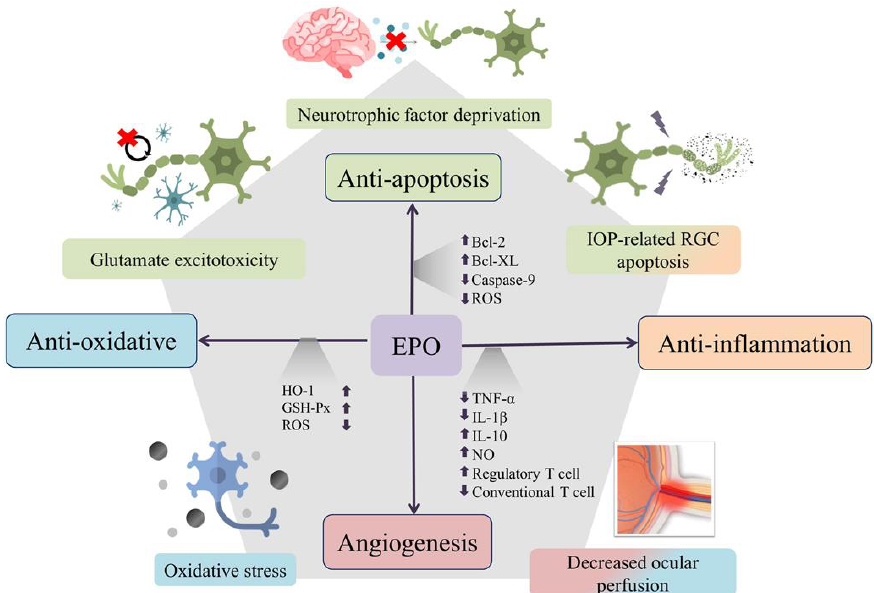
Figure 1. Erythropoietin (EPO) is neuroprotective through its antiapoptotic, antioxidative, and anti-inflammatory effects. The multifunctionality of EPO is used to target the multicausal mechanism of glaucoma. Through upregulation of antiapoptotic proteins Bcl-2 and Bcl-XL, inhibition of caspase-9 activation, and removal of reactive oxygen species (ROS), EPO can exert its antiapoptosis action against intraocular-pressure-related retinal ganglion-cell injury, glutamate excitotoxicity, and damage from neurotrophin factor deprivation. EPO can also increase levels of heme oxygenase-1 (HO-1) and glutathione peroxidase (GSH-Px) to reduce oxidative stress and can promote immunomodulation through decreased inflammatory cytokines, increased anti-inflammatory cytokines and enhance- ment of regulatory T-cell proliferation. Theoretically, the angiogenesis and antioxidative effects of EPO might also contribute some protective effects against injury from decreased ocular perfusion in